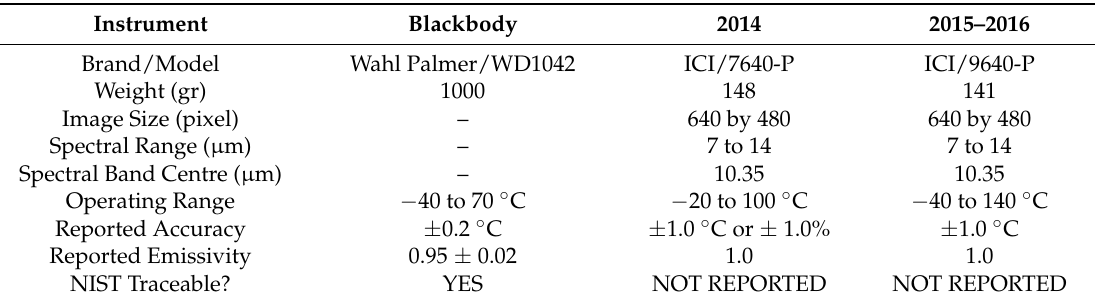
Table 1. Instruments used to collect temperature information in this study.